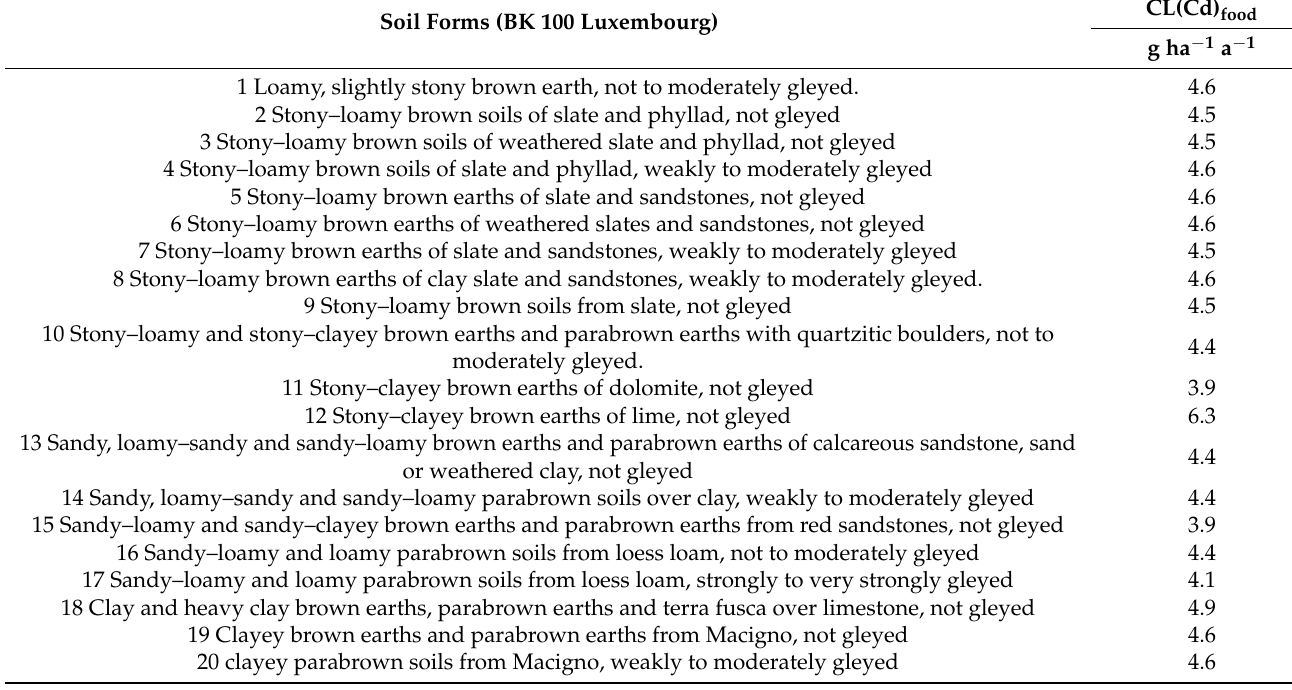
The results of the determination of critical loads for Cd in wheat and wheat products for the protection of human health are presented for the 27 soil types of the soil map 1:100,000 Luxembourg [31] differentiated in Table 18. Table 18. Critical loads for Cd in wheat and wheat products for the protection of human health in Luxembourg. Soil Forms (BK 100